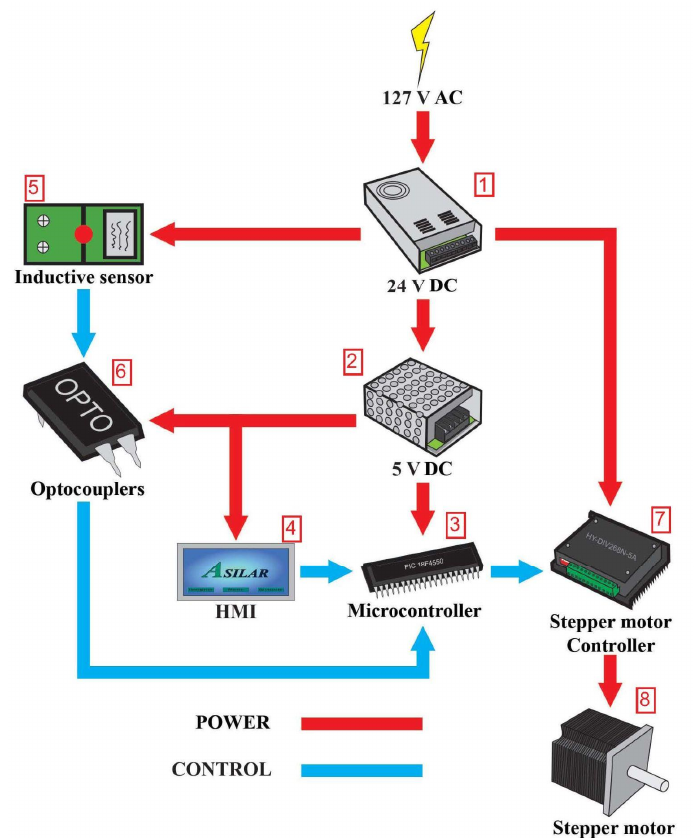
Figure 2. Automation system block diagram.